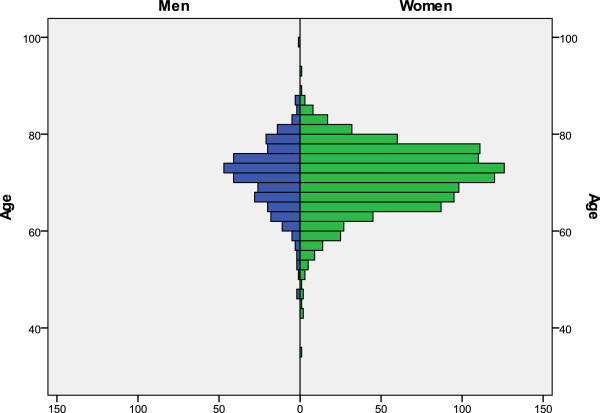
Age distribution by gender.